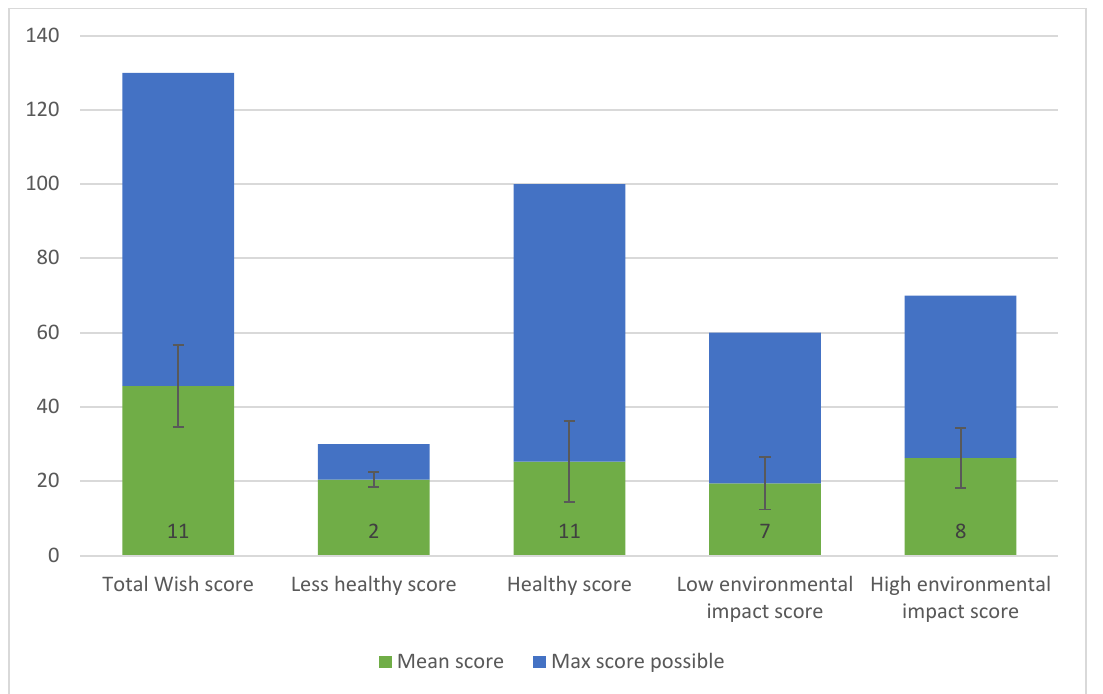
Figure 2. Total and sub-scores for the WISH in a Vietnamese population SDs are given below the error bars.